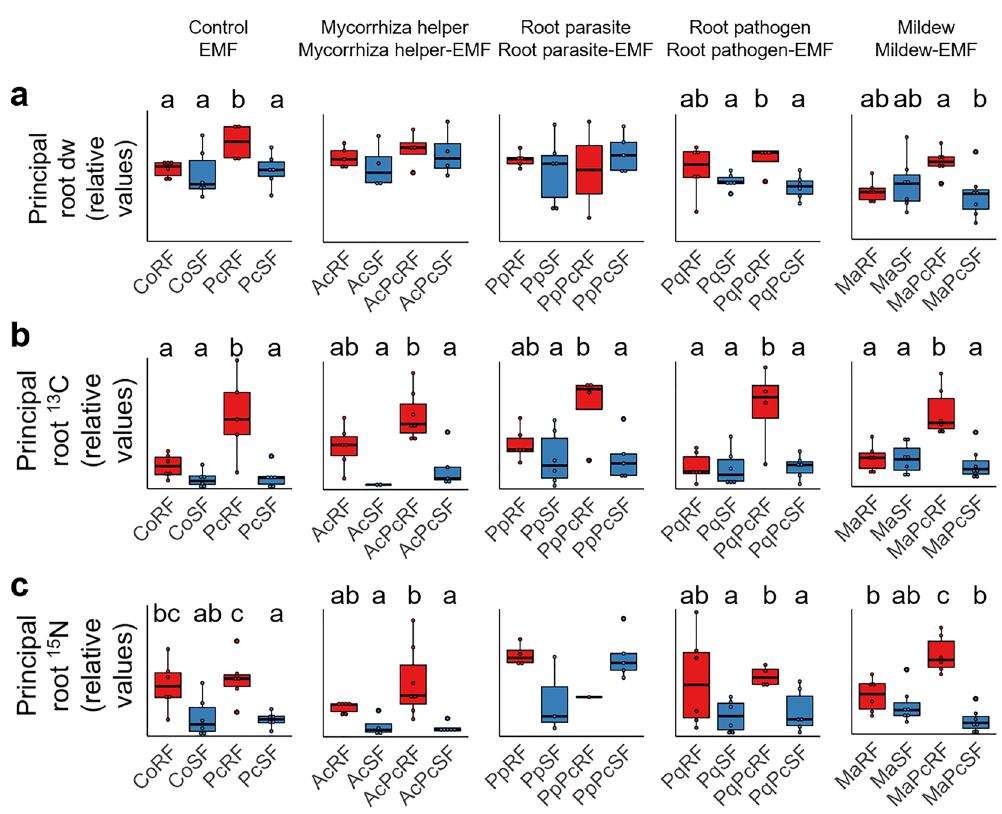
Figure 3. Rhythmic pattern of biomass partitioning and resource allocation is elicited by the ectomycorrhizal fungus in pedunculate oak principal roots. ( a ) Extent of biomass (g dry weight), ( b ) recently fixed carbon (excess of 13 C), and ( c ) recently fixed nitrogen (excess of 15 N) to the organs of oak during root and shoot flush in oak microcuttings engaged in biotic interactions. For the purpose of simplicity, relative values are shown here, and absolute values are given in Supplementary Fig. S3. Red colour marks RF and blue colour marks SF, and different letters indicate a significant difference according to linear model, ANOVA and Tukey’s test, at the significance level P < 0.05. Please refer to Supplementary Table S4 for the corresponding values. Where no lettering is included, the treatments were not different to each other. DW, dry weight; 13 C, allocation of C-13; 15 N, allocation of N-15; RF, root flush; SF, shoot flush; Pc, Piloderma croceum , Ac, Streptomyces sp. AcH505; Pp, Pratylenchus penetrans , Pq, Phytophthora quercina ; Ma, Microsphaera